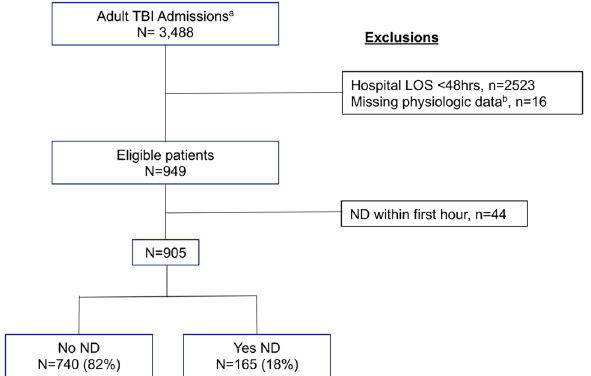
Figure 1. a All cases identified from trauma registry with Head AIS 1–5, Thoracic/Abdominal AIS ≤ 1 , and toxicology screen negative for opiates and cocaine, from Nov 2015–Jun 2018. b Cases included if ≥ 30% of first hour continuous physiologic data was available for analysis. TBI = traumatic brain injury; LOS = hospital length of stay; ND = neurologic